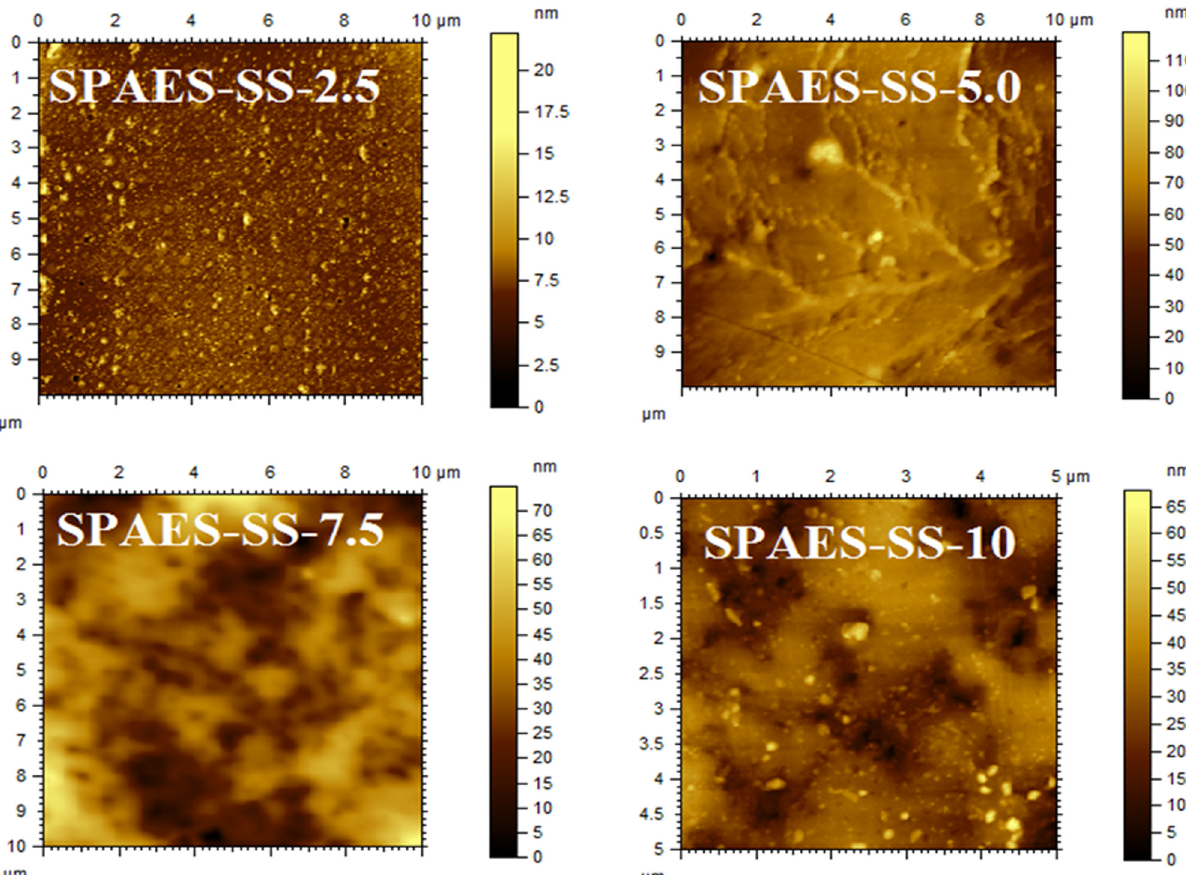
Figure 8: 2D tapping mode AFM images SPAES - SS - X composite